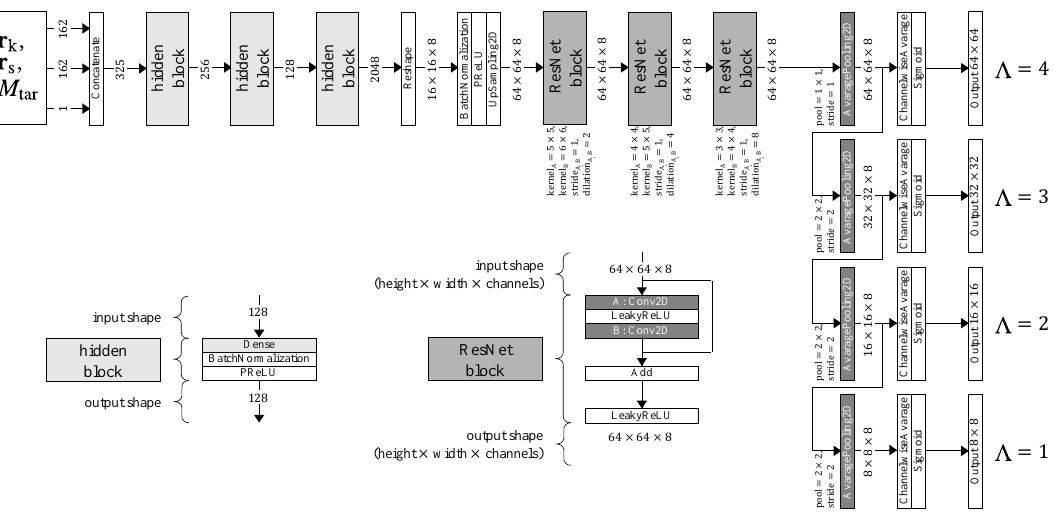
Figure 10. Predictor’s artificial neural network (ANN)